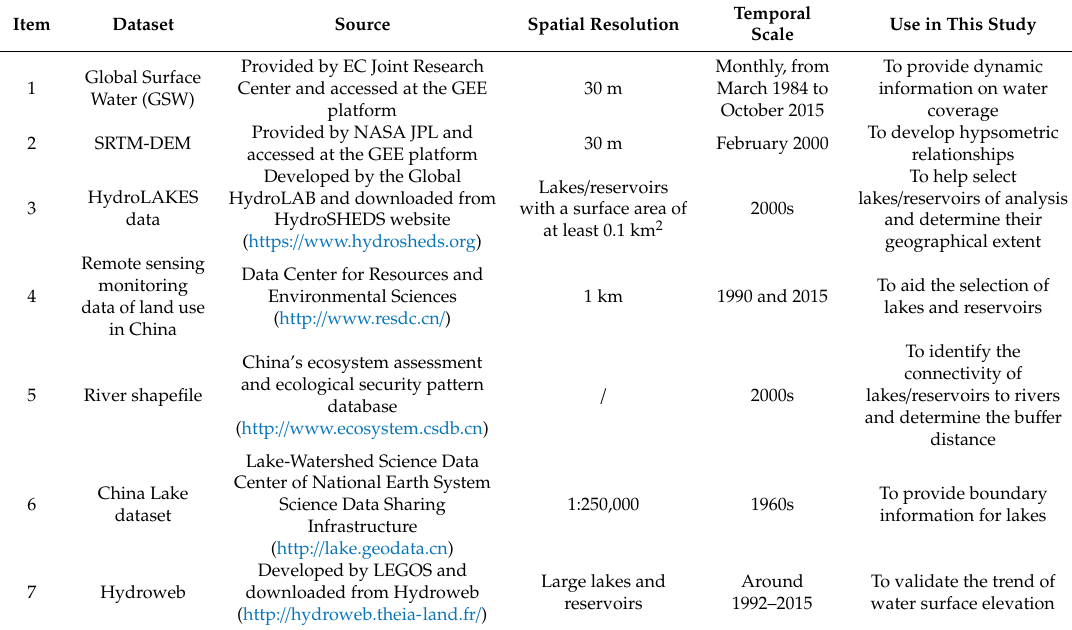
Table 1. List of the dataset used in this